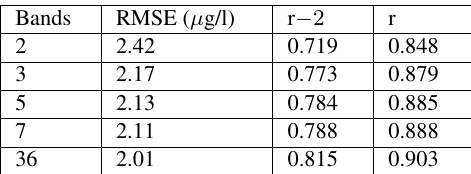
Table 1. Statistics of the regression models: Root mean square error (RMSE), correlation coefficient r and coefficient of determination r 2 .